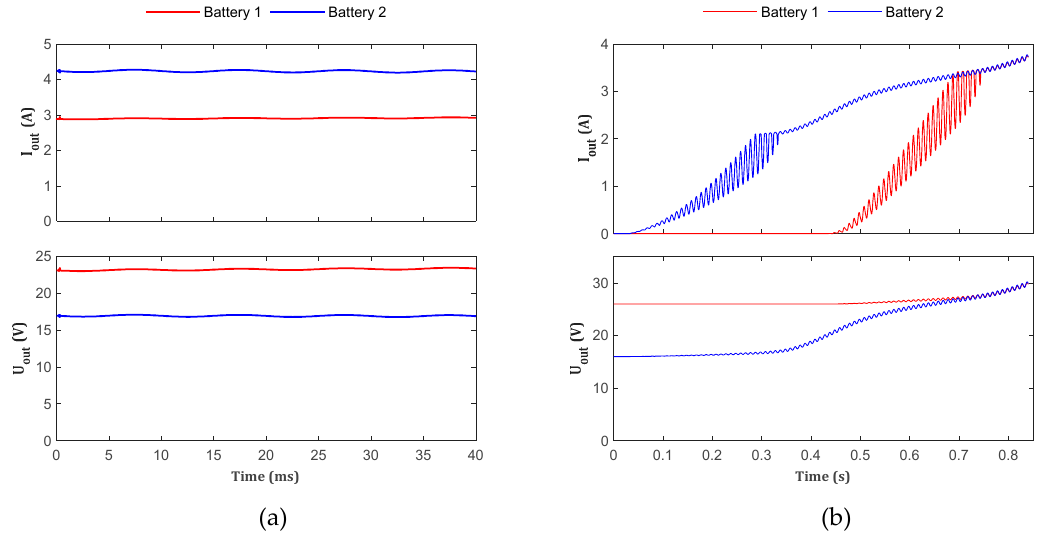
Figure 16. Output current and voltage waveforms of two separate SEPIC cells operating with different loads (a); charge balancing at the output capacitances of parallel connected cells (b).